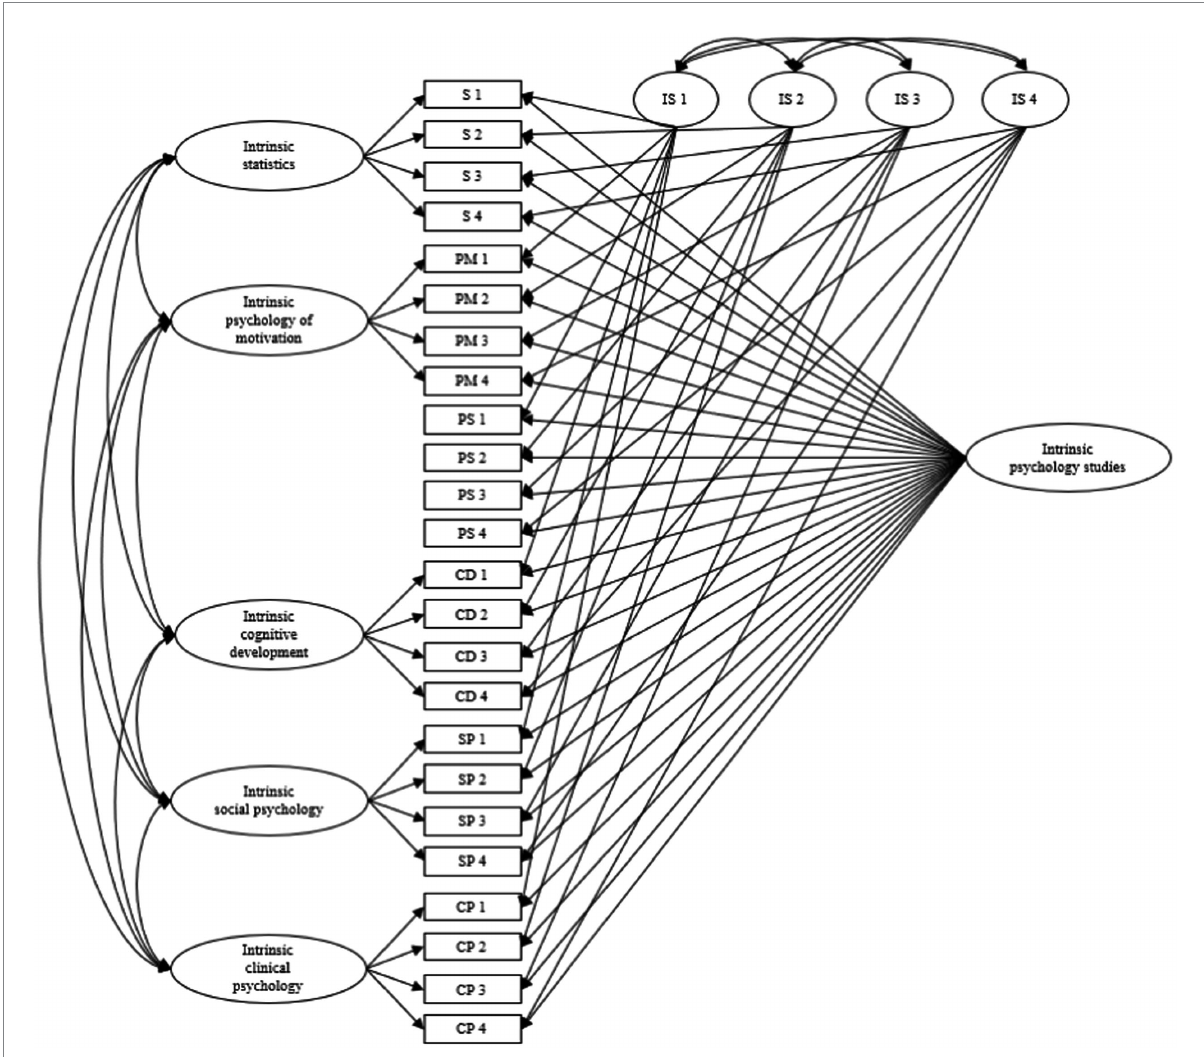
FIGURE 1 CTCM-1 Model for Intrinsic Motivation. 1–4 = items for statistics; PM 1–4 = items for psychology of motivation; PS 1–4 = items for psychology studies; CD 1–4 = items for cognitive development; SP 1–4 = items for social psychology; CP 1–4 = items for clinical psychology; IS 1–4 = item- specific factors.